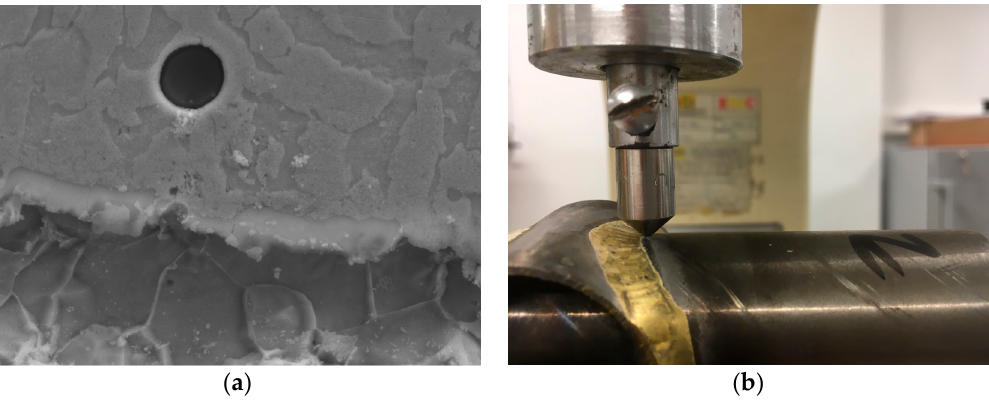
Figure 3. ( a ) Scanning electron microscopy (SEM) at the bimetallic bond between steel and brass (Cu60%, Zn38%). The strength of this interaction (i.e., the chemical compatibility) will determine the strength of the joint and the minimum fillet size; ( b ) Tests to determine the hardness in the heat- affected zone